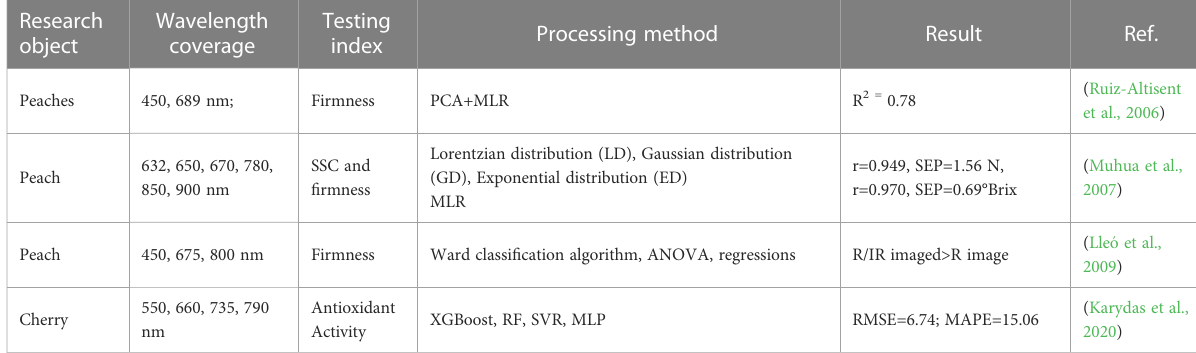
TABLE 7 Summary table of fruit maturity and biochemical parameters detection based on multispectral image.